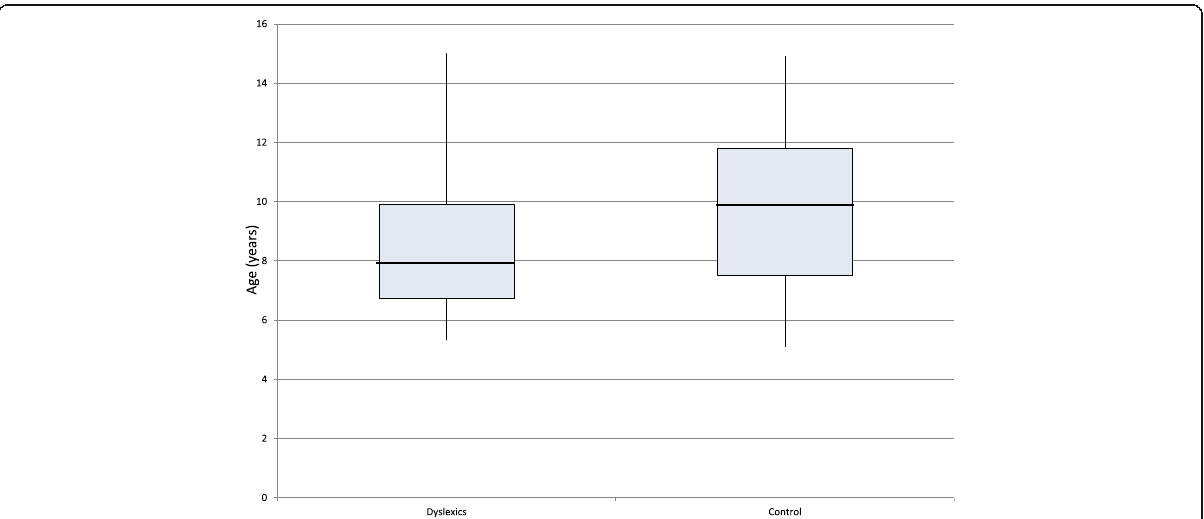
Fig. 1 Box and whisker graph of age (years) in the studied groups; the thick line in the middle of the box represents the median, the box represents the inter-quartile range (from 25th to 75th percentiles), and the whiskers represents the minimum and maximum after excluding outliers (black-filled circles). (Numbers indicate the serial number of the patient in the original master